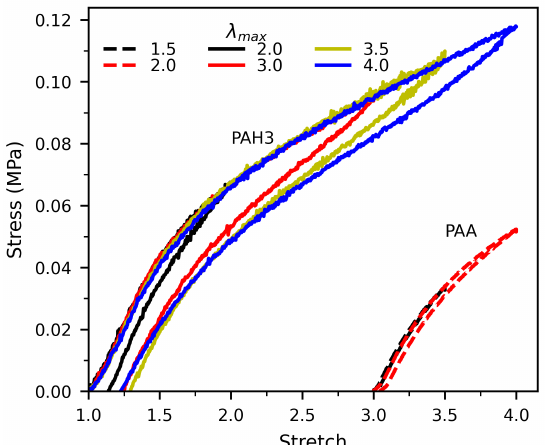
Figure 8. Stress–stretch curves for hydrogels of PAA and PAH3 (14% HBP3), subjected to a loading– unloading cycle with different maximum stretches, λ max .